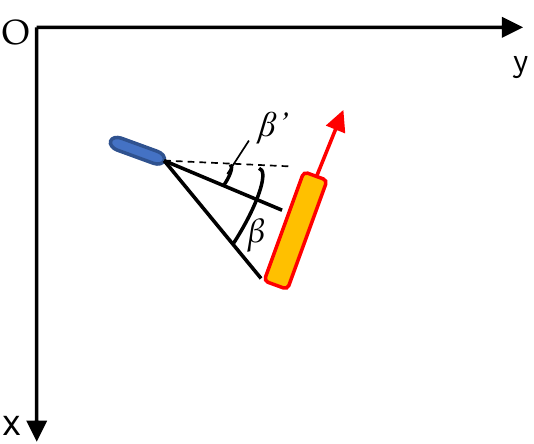
Figure 3. Avoid static obstacles.